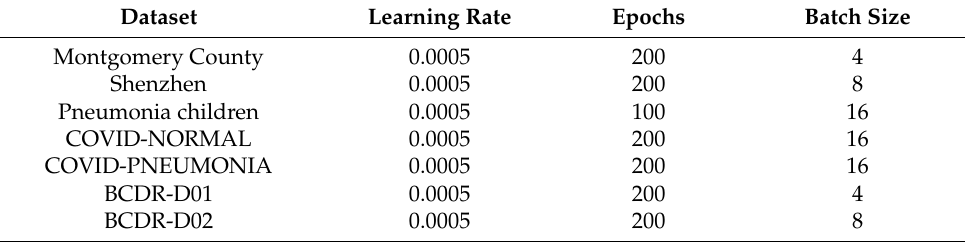
Table 7. Hyperparameters for each